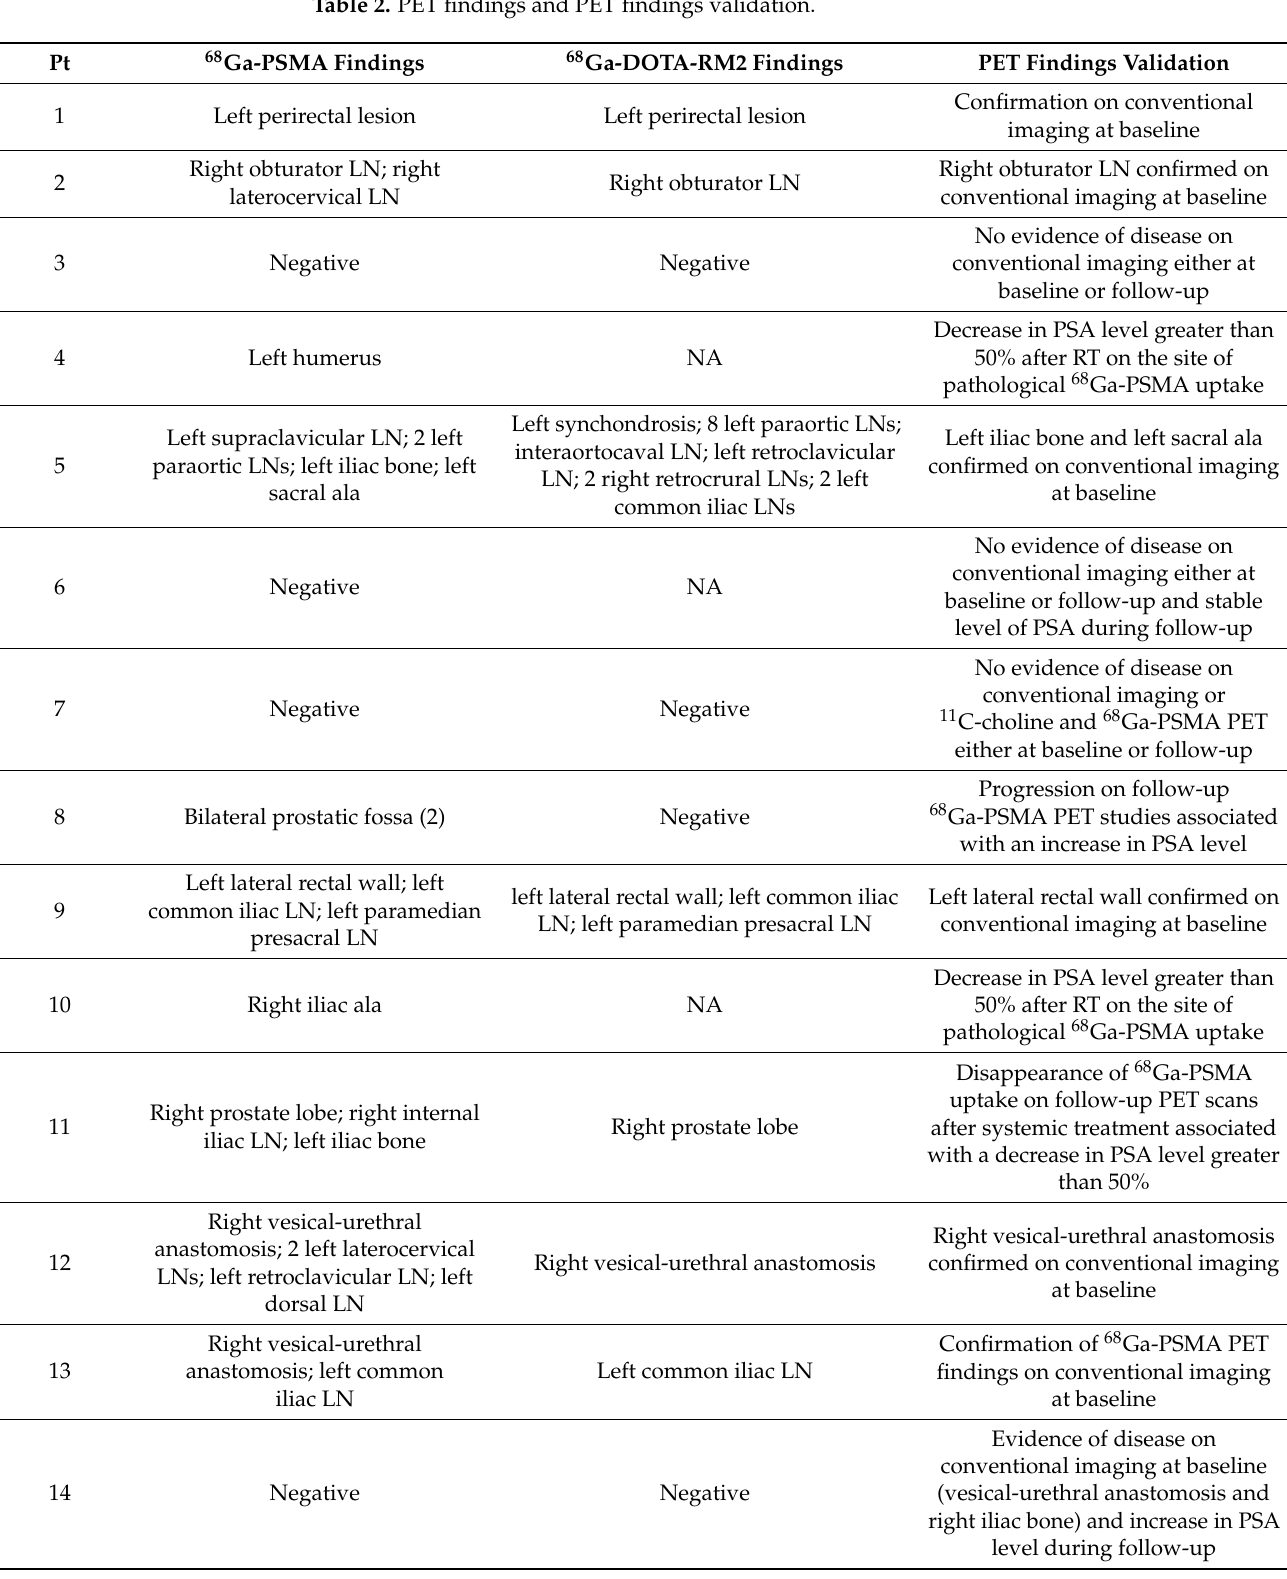
Table 2 for detailed information on the follow-up examination for each patient. Table 2. PET findings and PET findings